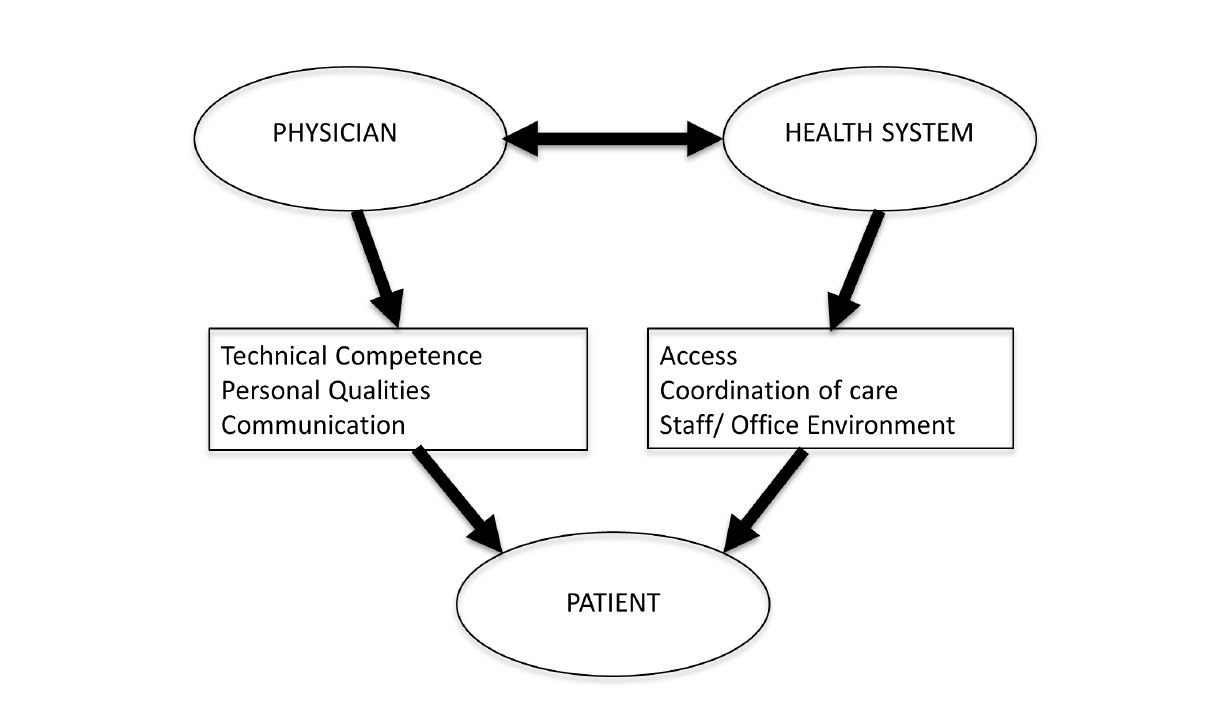
Figure 2. Conceptual